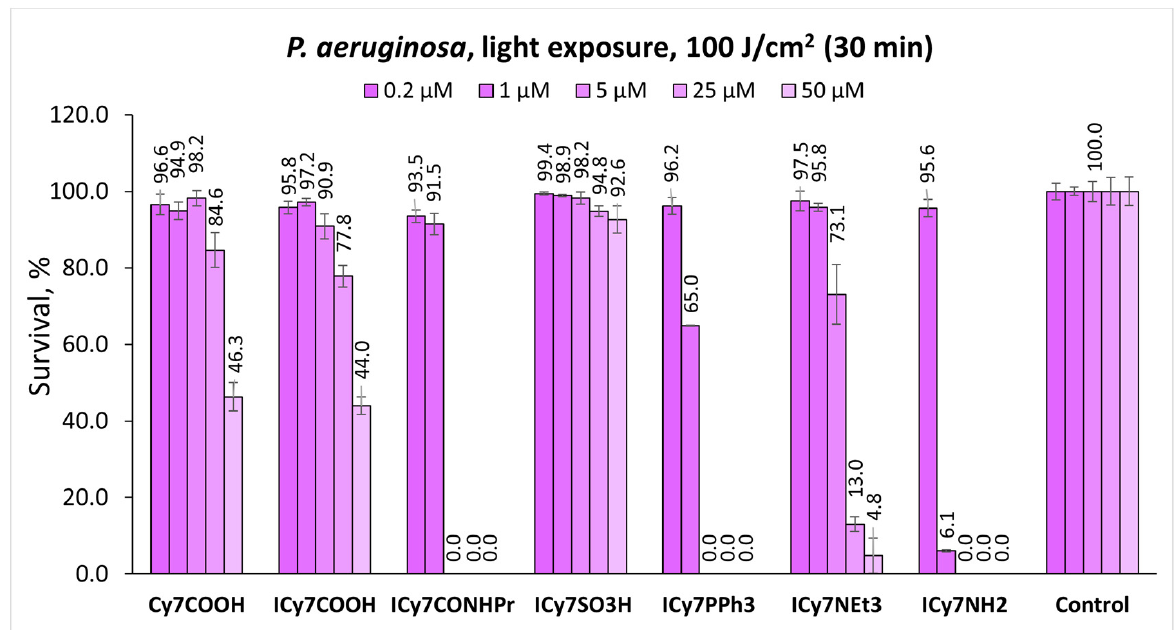
Figure 7. Survival of P. aeruginosa in saline containing 0.7% DMSO, when exposed to 100 J/cm 2 light dose (56 mW/cm 2 , 30 min) vs. the dye concentrations.